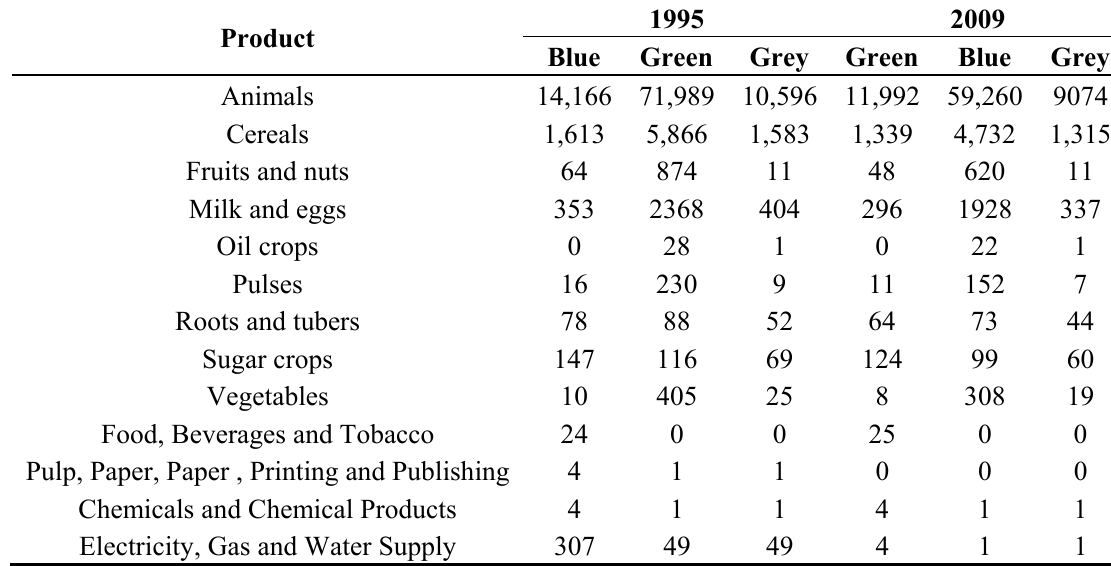
Table 3. Water embodied in Spanish food sector purchases from domestic sectors, thousand m 3